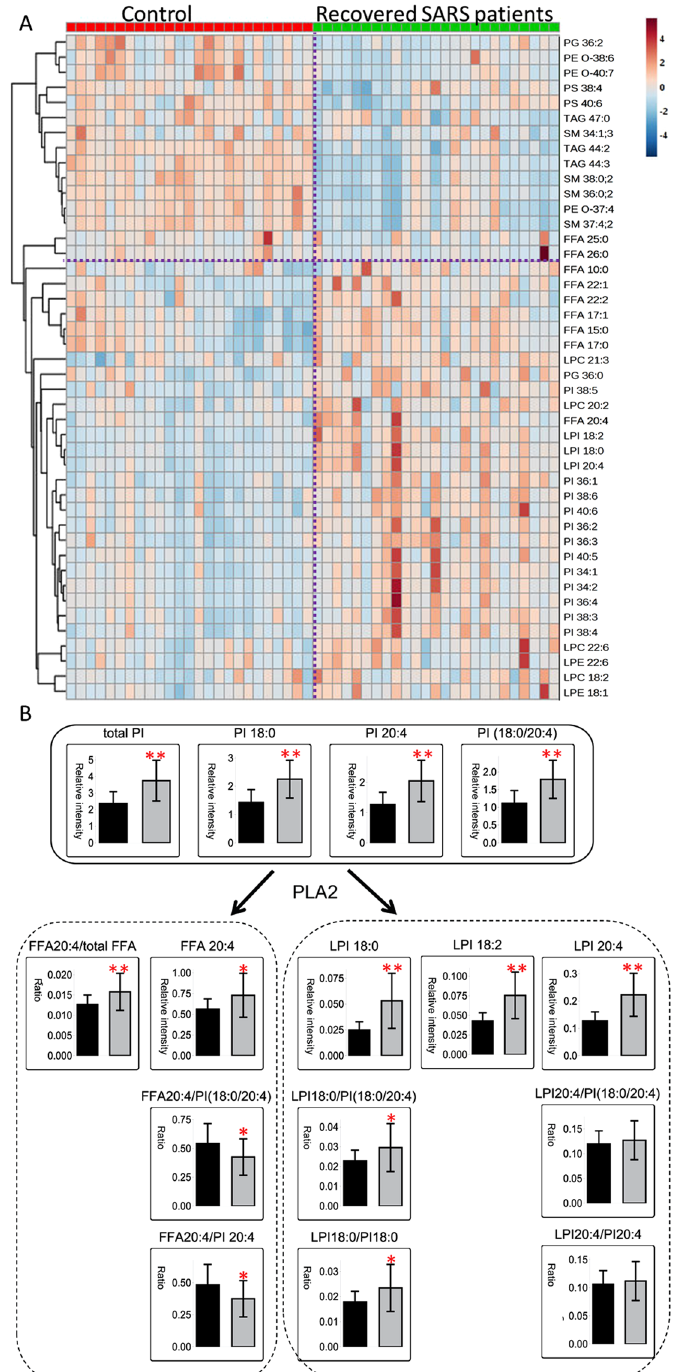
Figure 6. ( A ) Cluster analysis of differentially expressed lipids. ( B ) Fatty acids as a result of phosphatidylinositol remodeling in recovered SARS patients sensitive to phospholipase